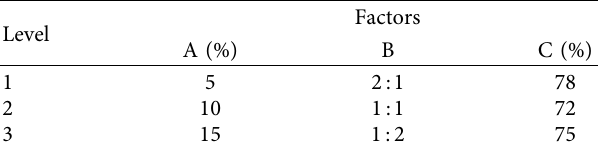
Table 1: Orthogonal test factor level.